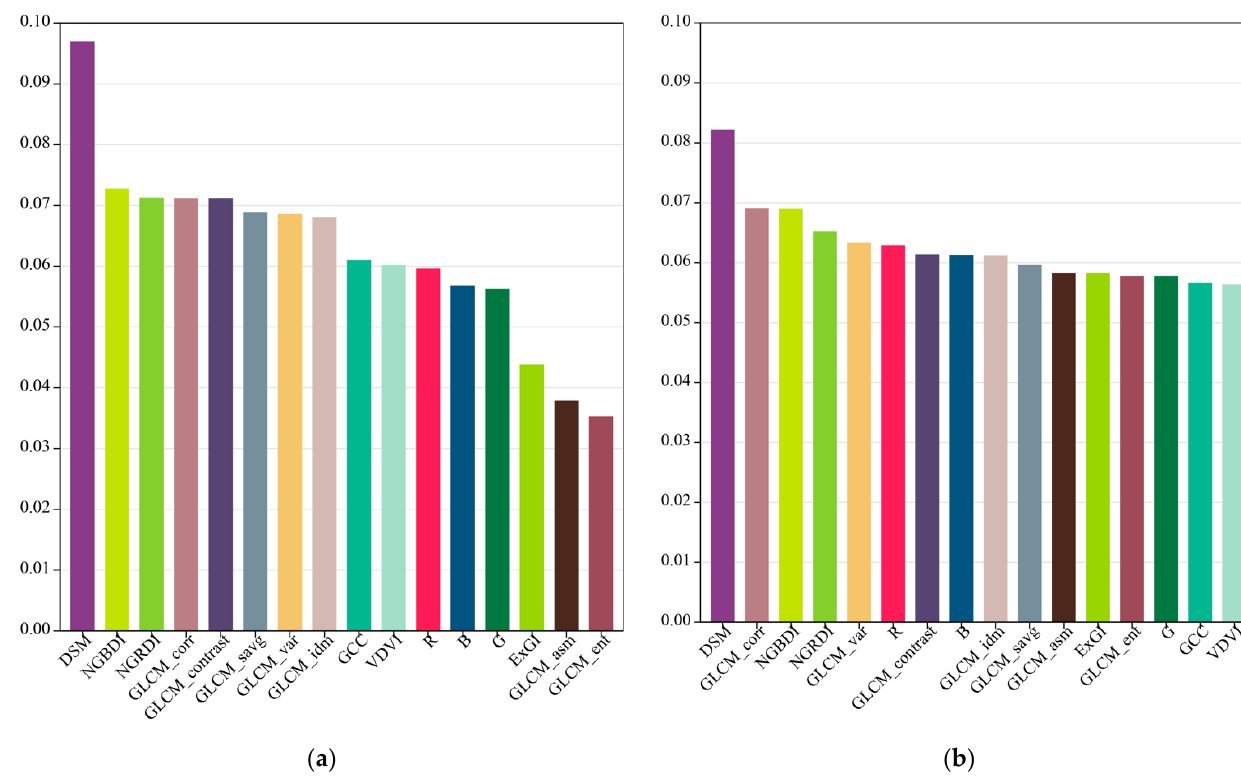
Figure 5. Relative Feature Importance of random forest in PB and OBIA Classification. ( a ) PB classification; ( b ) OBIA classification.